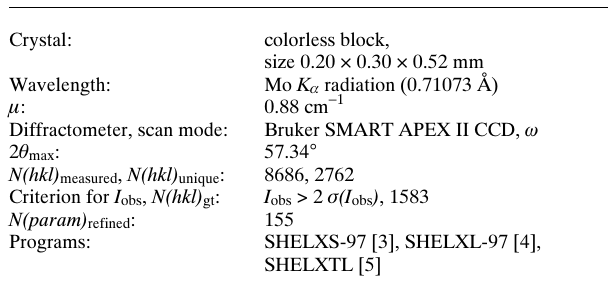
Table 1. Data collection and handling.